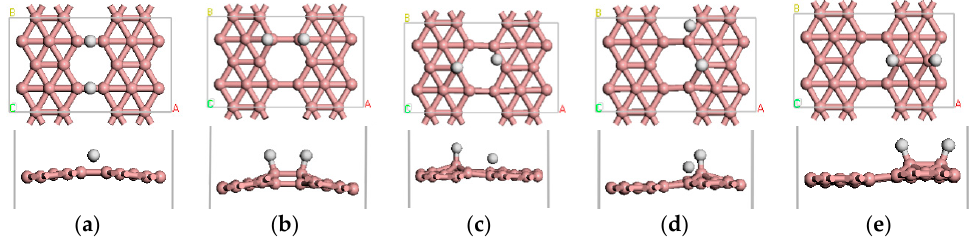
Figure 2. ( a – e ) show the five stable optimized geometrical structures of β 12 -borophene/H